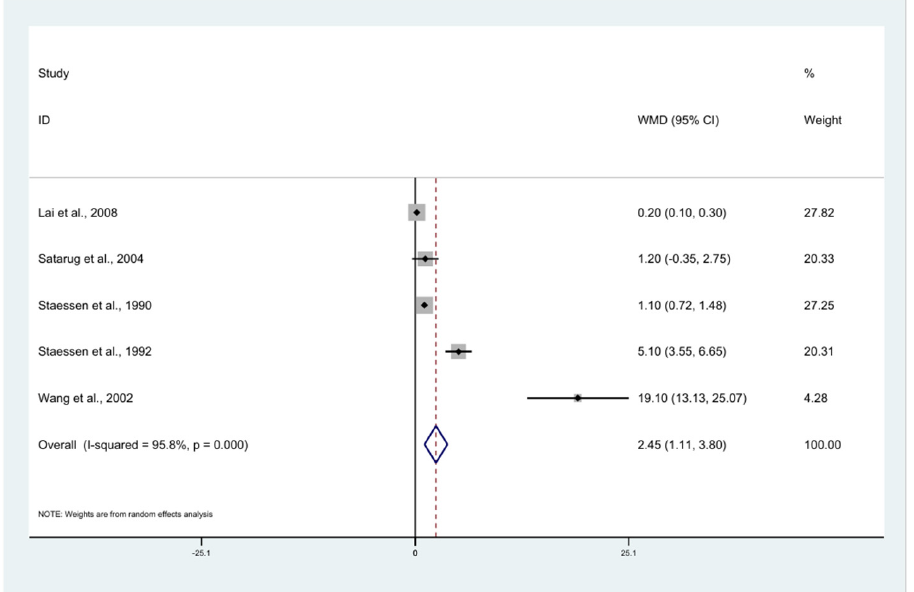
Figure 4. The mean difference in BLL between male and female participants. The mean BLL in the exposed males was higher than that in the female participants (weighted mean difference: 2.45, p < 0.0001, 95% CI: 1.11–3.80, I 2 : 95.8%) (white diamond symbol). WMD: Weighted Mean Difference (µg/dL), % Weighted: the impact proportion of each study to the pooled effect, CI: Confidence Interval (µg/dL), Black diamond symbol: point estimate for each study, White diamond symbol: pooled WMD in each subgroup or all groups, Solid line in the middle of the graph at 0: no difference in WMD between the two groups, Dashed line: pooled WMD between the two groups.